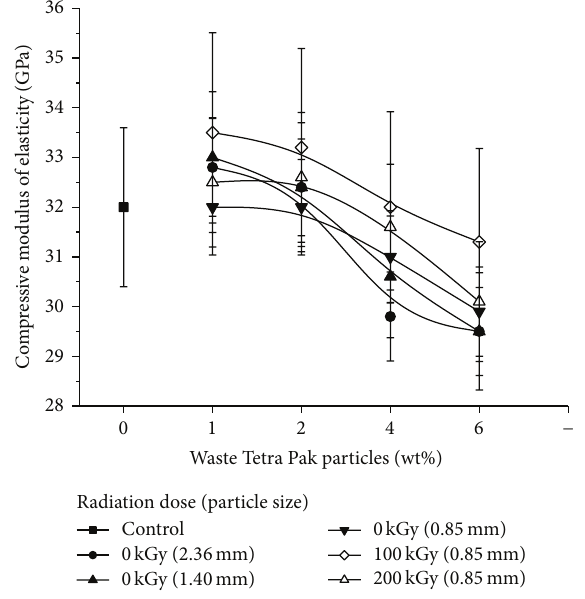
Figure 8: Compressive modulus of elasticity of polymer concrete at different particle